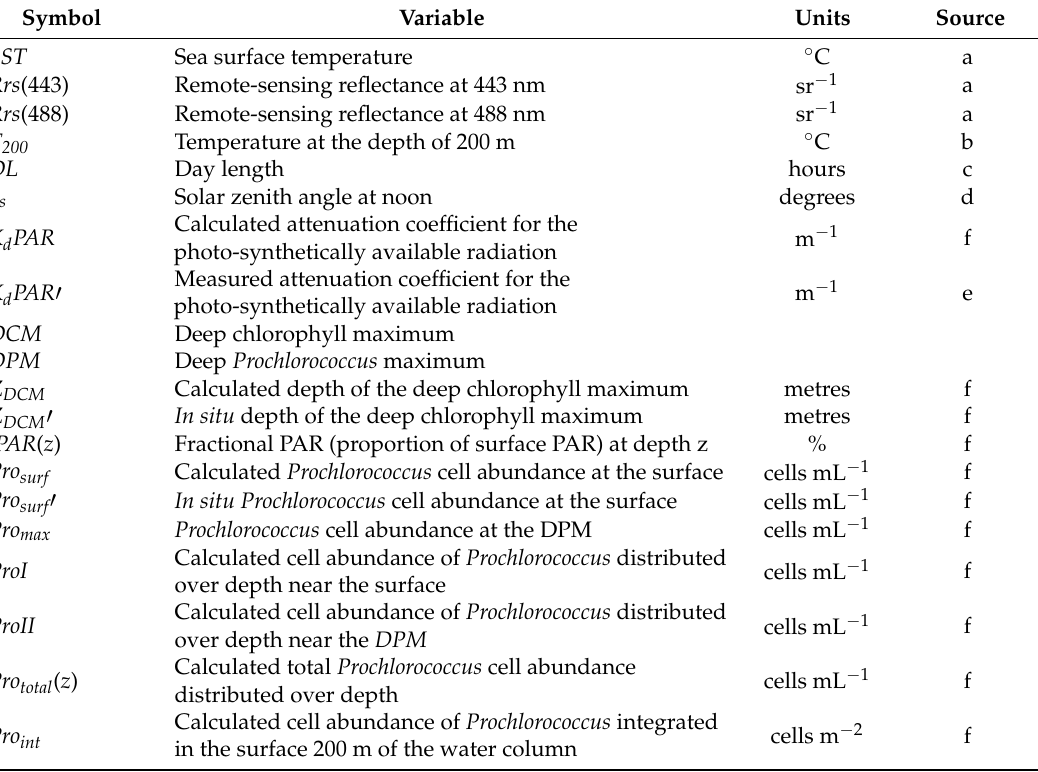
Figure 2. Flowchart of computations used to calculate the cell abundance of Prochlorococcus . Variable acronyms and symbols are described in Table 1. Table 1. List of acronyms and symbols used in this manuscript (input variables used in the predictive model of Prochlorococcus cell abundance).